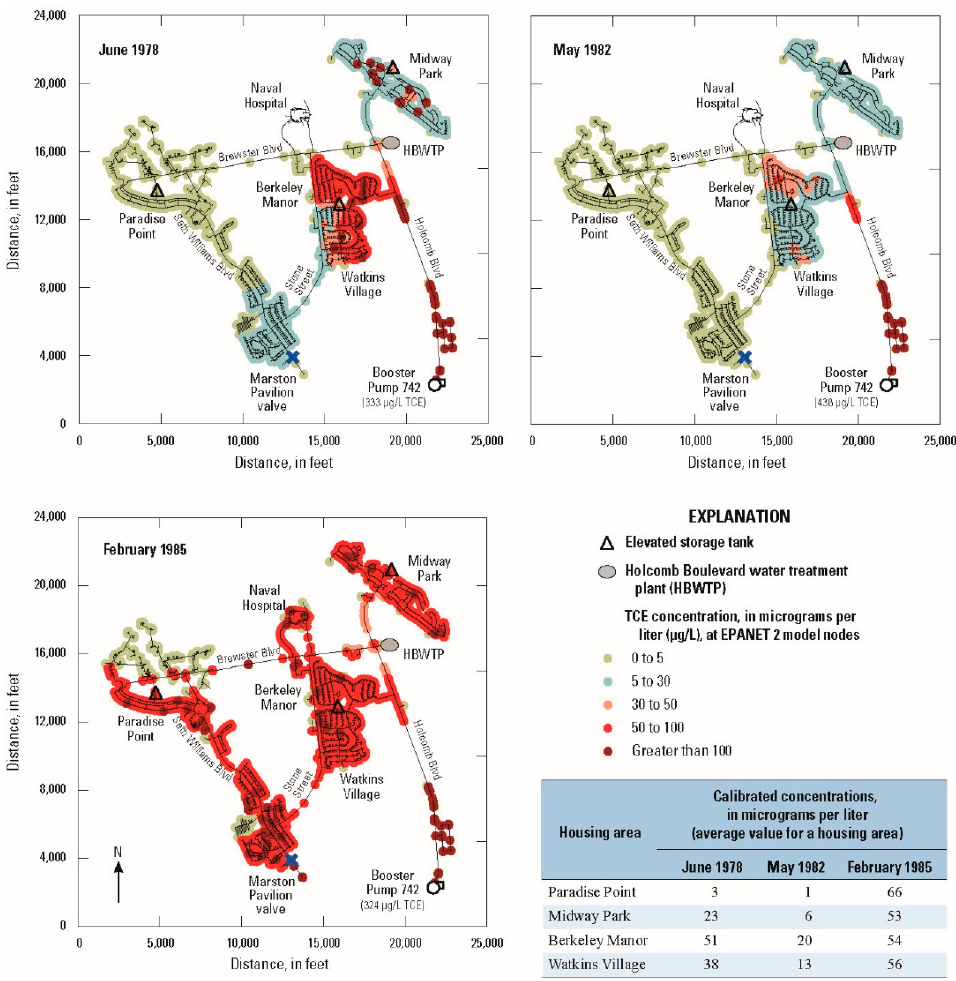
Figure 5. Reconstructed (simulated) distribution of trichloroethylene (TCE) contamination within the Holcomb Boulevard water treatment plant service area resulting from supply of contaminated Hadnot Point drinking water, June 1978, May 1982, and February 1985 (from [1,12]; 1 ft = 0.3048 m).